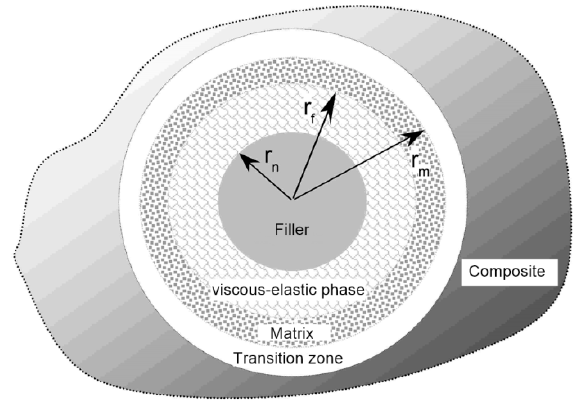
Figure 2. Conception of the “polymer–filler” interphase.